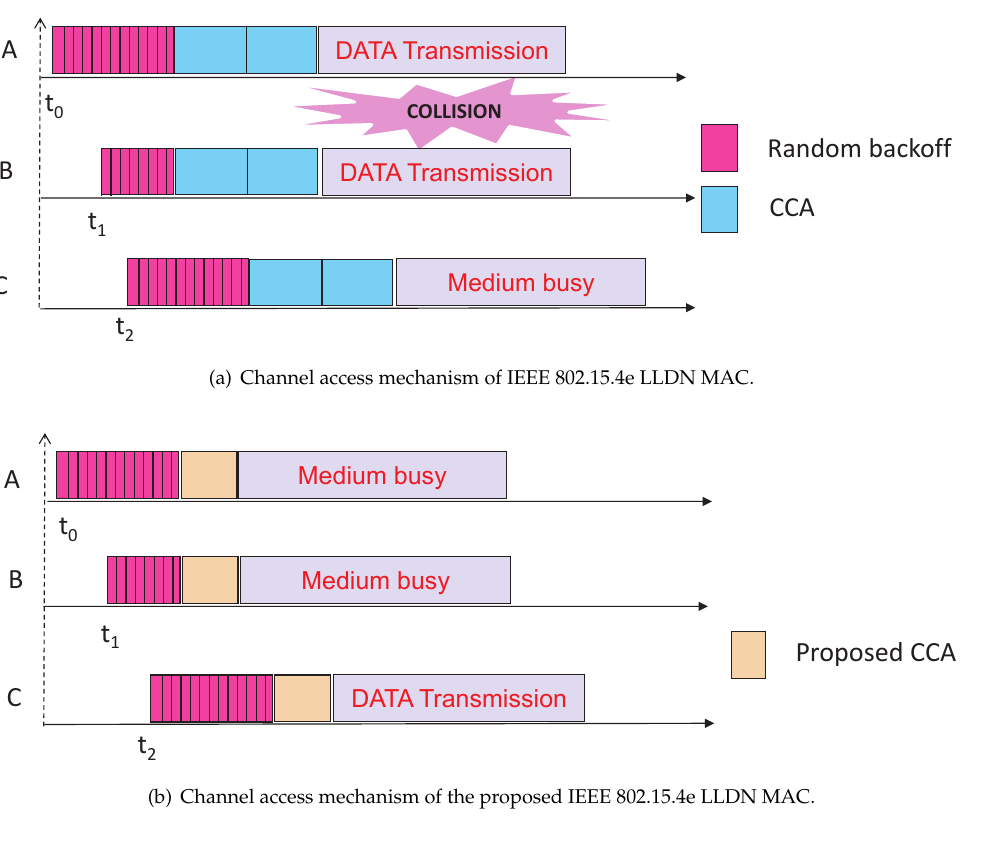
Figure 2. Channel access mechanism.